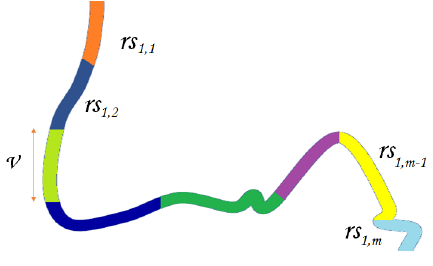
Figure 13. Segmentation of a route ( r 1